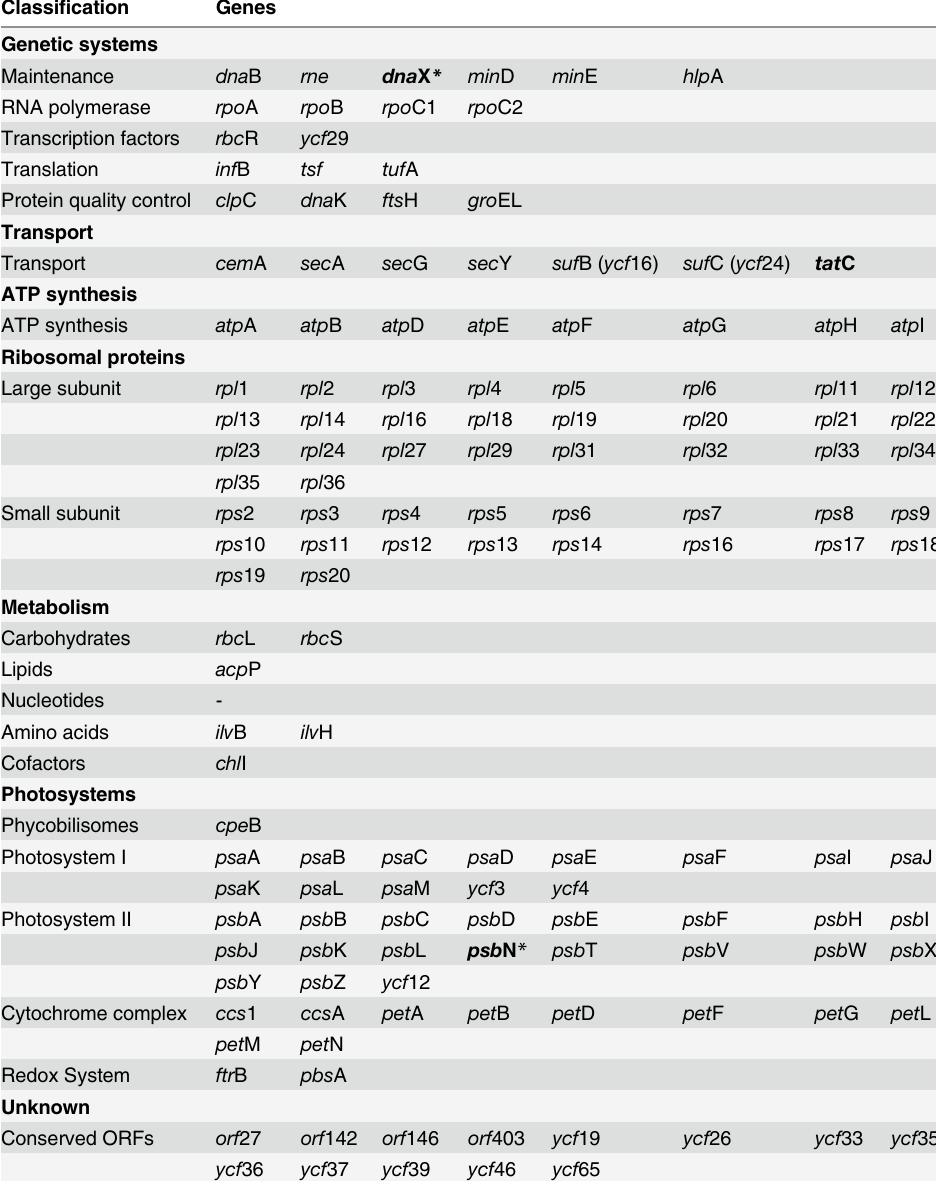
Table 3. List of genes in the Teleaulax amphioxeia plastid genome (143 total). Classi fi cation